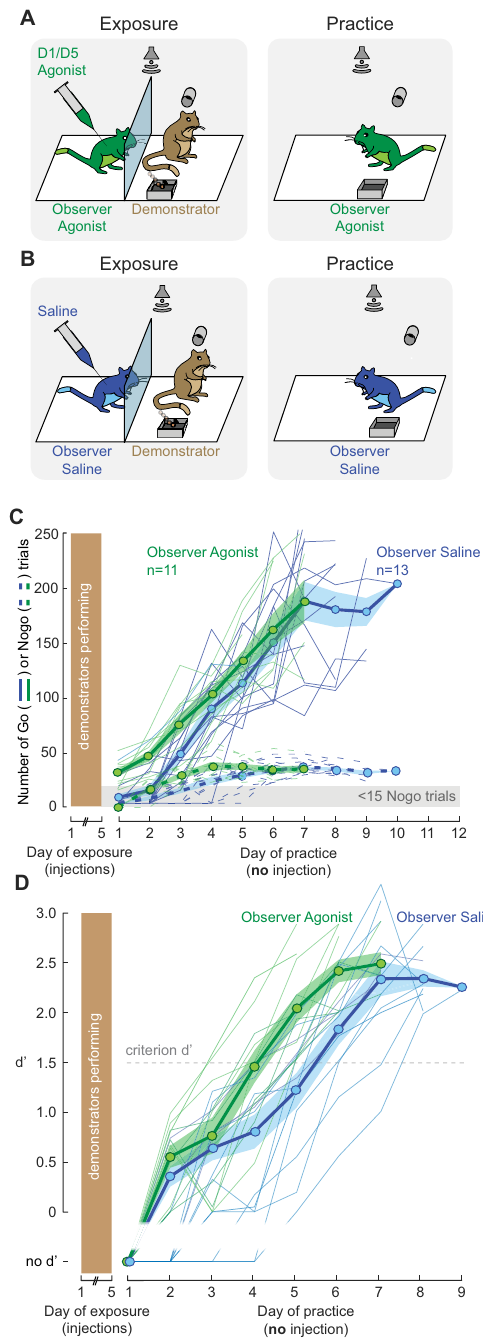
Figure 3. Increase of tonic dopamine level enhances social learning. ( A ) Prior to each exposure session, the naïve observer gerbils were given an injection of a dopamine receptor agonist (6 males; age = 100.3 ± 12 days; see “Methods” section for details). After 15–20 min of recovery, the exposure session began (left) with the demonstrators (age = 139 ± 5.2). No drug was injected during the practice sessions (right). ( B ) Similar to A, except that saline was injected to the observers (5 males; age = 104.3 ± 10.7) prior to each exposure session (left) with the demonstrators (age = 163 ± 5.4). No drug was injected during the practice sessions (right). ( C ) Individual and mean ± SEM of the overall number of Go and Nogo trials performed by the observer gerbils during the practice sessions (agonist-injected observers in green and saline-injected observers in blue). ( D ) Individual and mean ± SEM of the performance d ′ of the observer gerbils as a function of practice